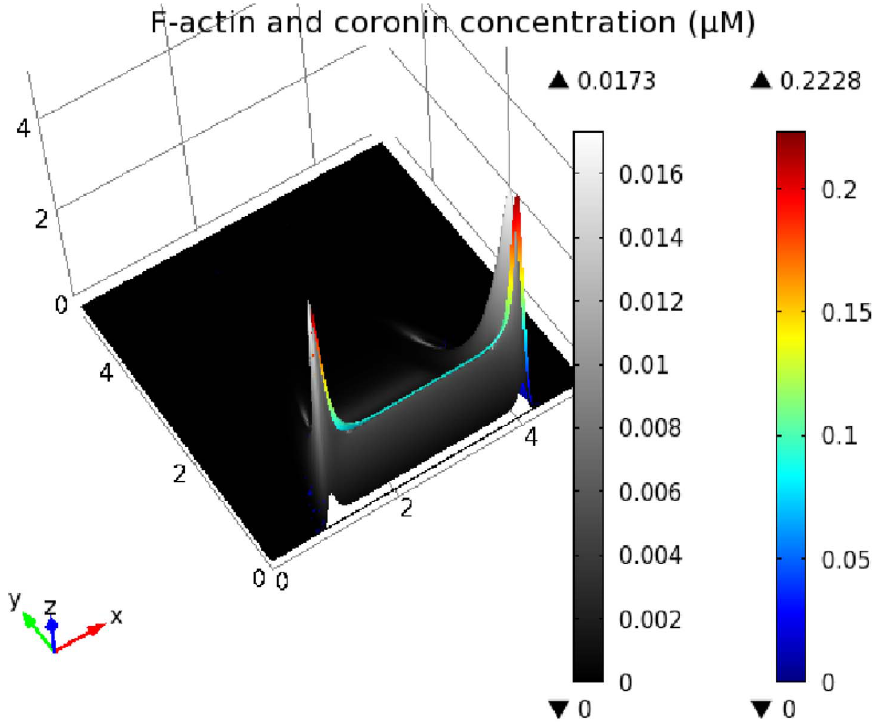
Figure 12. Relative coronin localization on the F-actin network in actin waves. Concentration of F-actin (right bar) and coronin-bound pointed ends (left bar) is plotted together, showing relative localization on the actin waves. The height displays relative concentration levels.